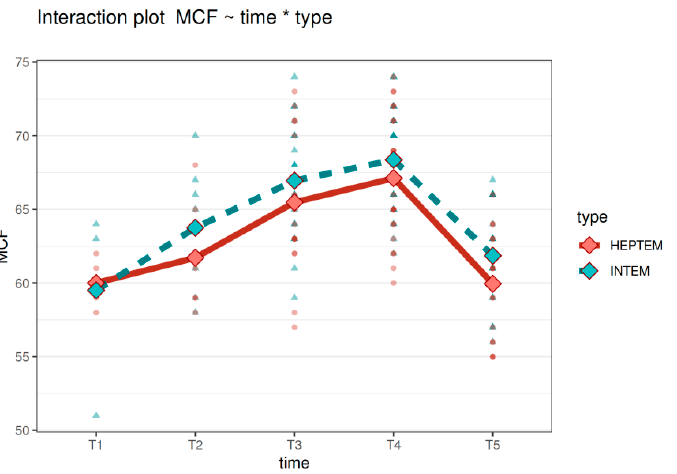
Figure 11. The interaction plot for MCF in HEPTEM and INTEM. In addition to the data points, the plot depicts the average value of MCF for HEPTEM (in red) and INTEM (in green) at different time points. Legend: MCF—maximum clot firmness, T1—time interval 1, T2—time interval 2, T3—time interval 3, T4—time interval 4, T5—time interval 5.